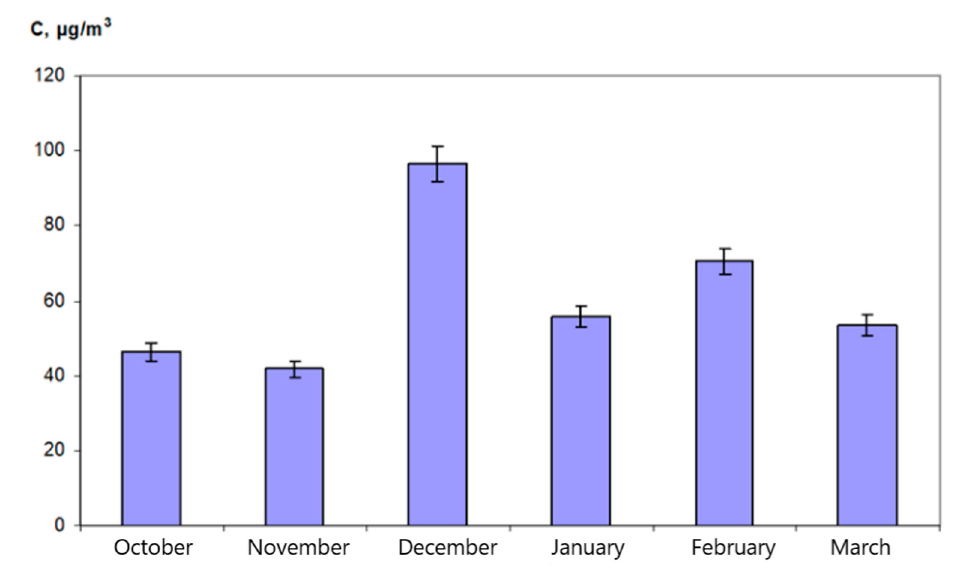
Figure 1. Distribution of daily PM 10 concentrations ( μ g/m 3 ) in Chelyabinsk city in autumn ‐ winter